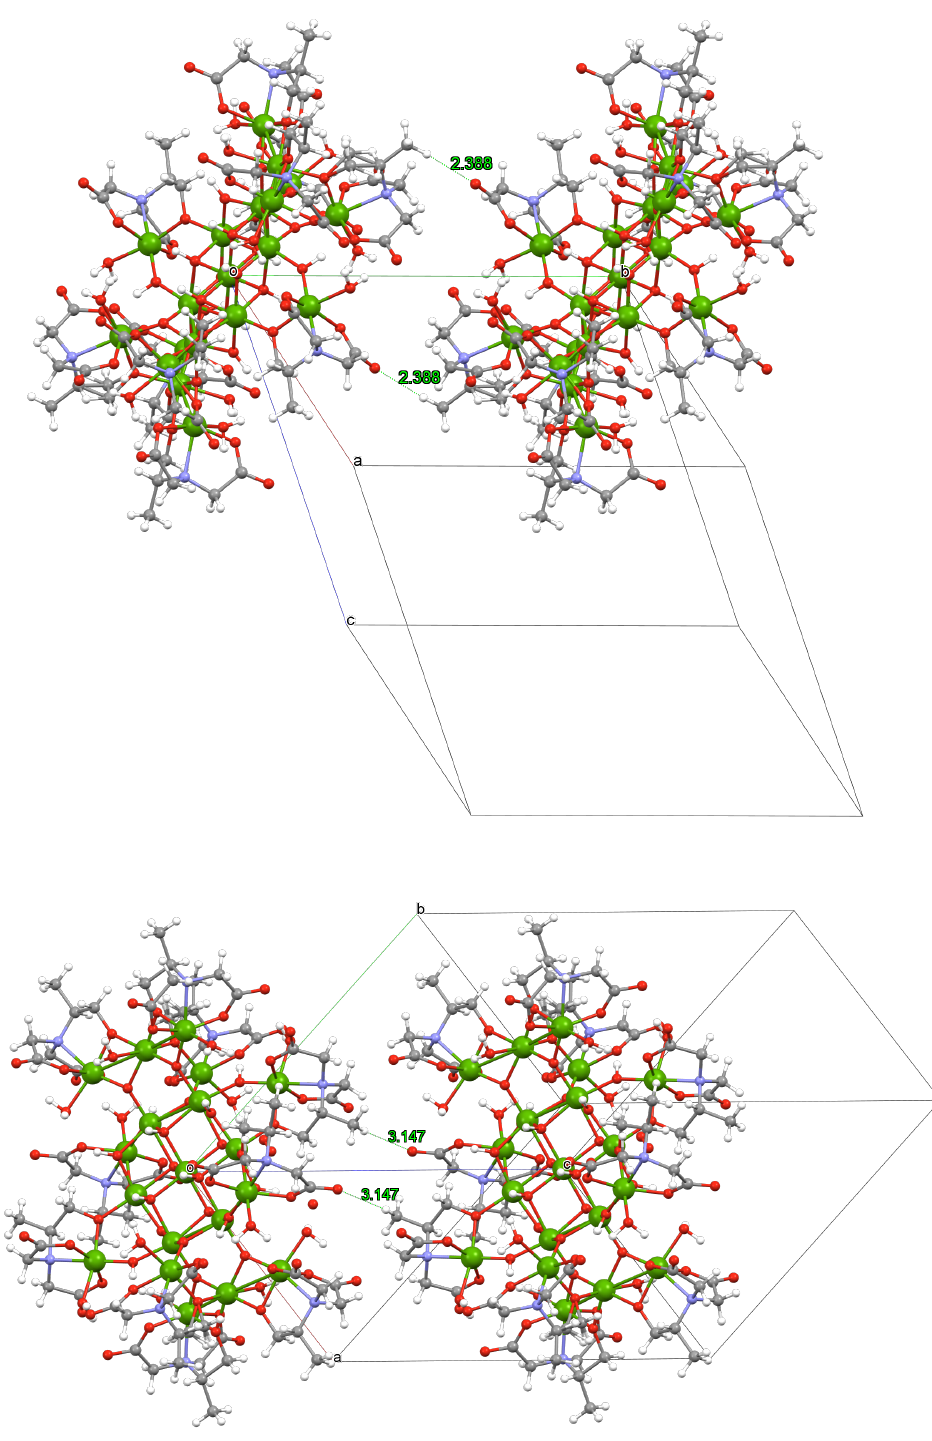
Figure 6. The shortest direct hydrogen bonds between molecules shown as green dotted lines for molecules displaced in the b direction ( top ) and the c direction ( bottom ). Oxygen atoms are shown as red and hydrogen atoms as light grey. The lengths are marked in Å (see Table